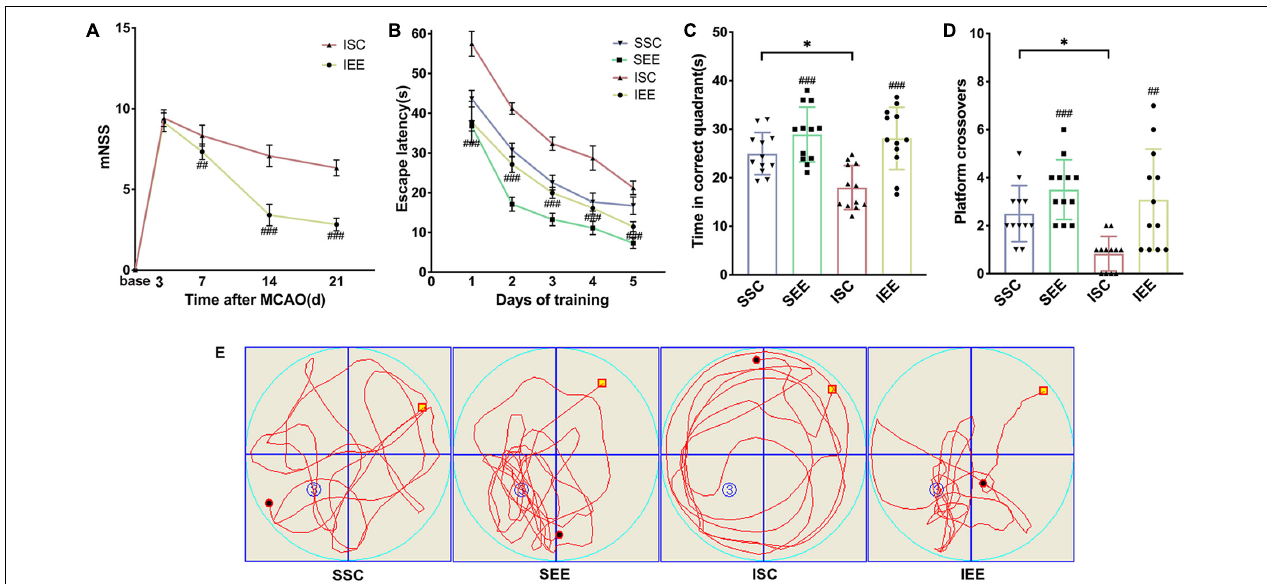
FIGURE 2 | Enriched environment improved long-term neurobehavioral function of MCAO/R rats. (A) The mNSS of ISC and IEE group. Rats were tested before MCAO surgery. (B) The escape latency in the spatial learning phase. (C,D) Time in the correct quadrant and the crossovers in the target quadrant was recorded and analyzed. (E) Representative swimming trajectories of SSC, SEE, ISC, and IEE group in the probe trials. n = 12. Data are expressed as mean ± SD. * p < 0.05 vs. SSC group; ## p < 0.01, ### p < 0.001 vs. ISC group.